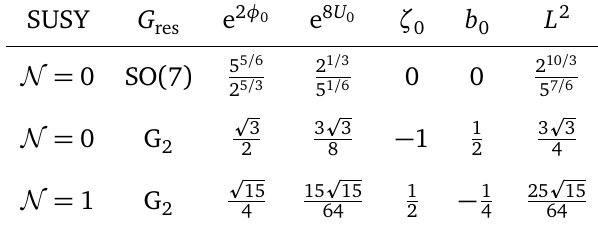
Table 1: The values of the scalars and AdS G denotes the residual symmetry of the ten-dimensional solution for the case where res = S 6 M 6